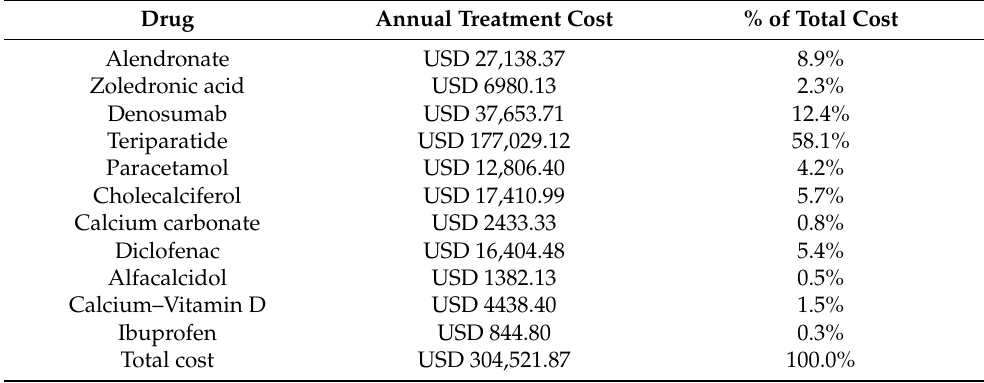
Table 4. Costs of medications for the treatment of osteoporosis during the study